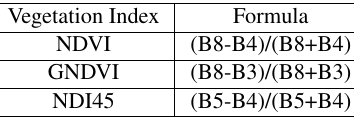
Table 1. Vegetation indices with Sentinel-2 bands configurations Vegetation Index